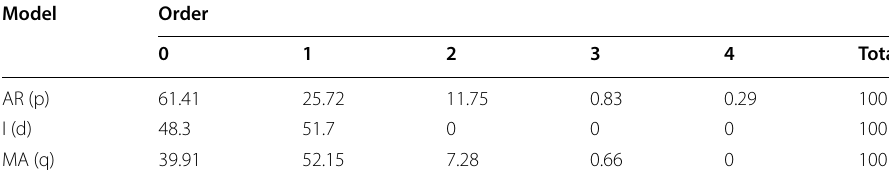
Table 1 Percentage of parameter values selected for model (1)